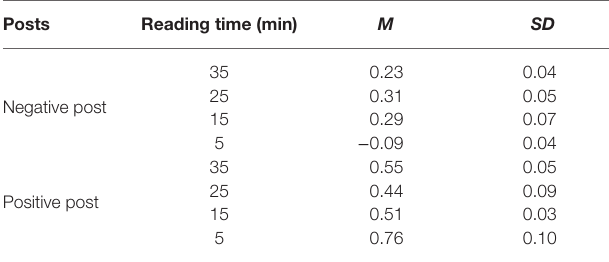
TABLE 4 | D-values of SC-IAT after reading posts ( N = 240).